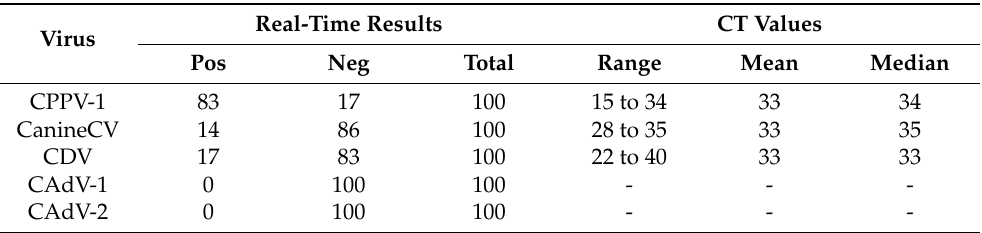
Table 1. Screening results for Carnivore Protoparvovirus 1 (CPPV-1), canine circovirus (CanineCV), canine distemper virus (CDV), and canine adenovirus type 1 and 2 (CAdV-1/2).